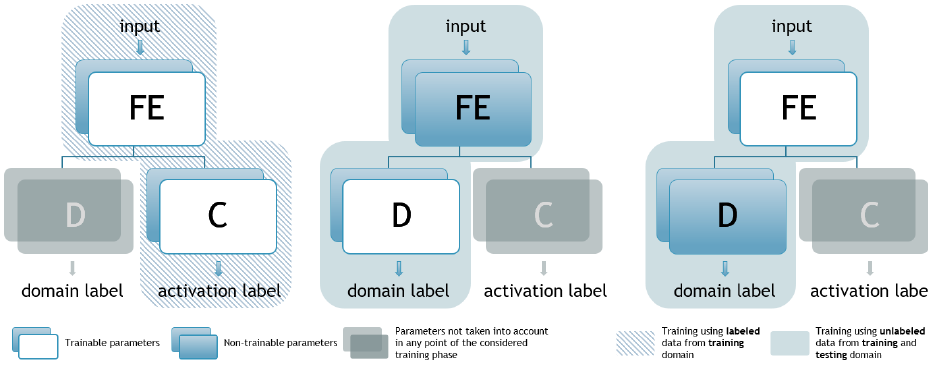
Figure 2. DANN training process (FE—feature extractor, C—classifier, D—discriminator).